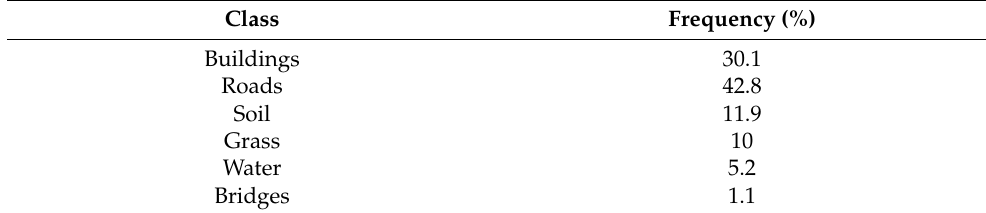
Table 1. Frequency of each class in the